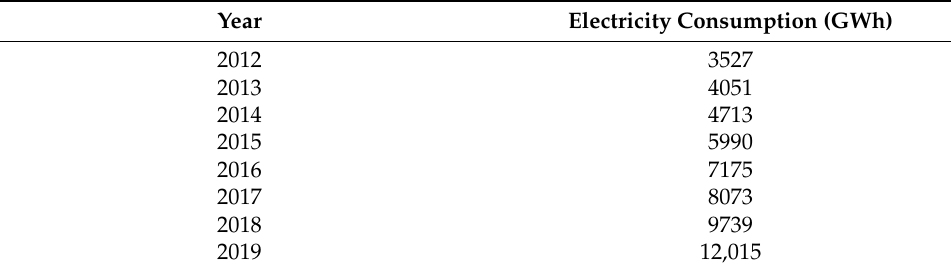
Table 1. Electricity consumption in Cambodia,